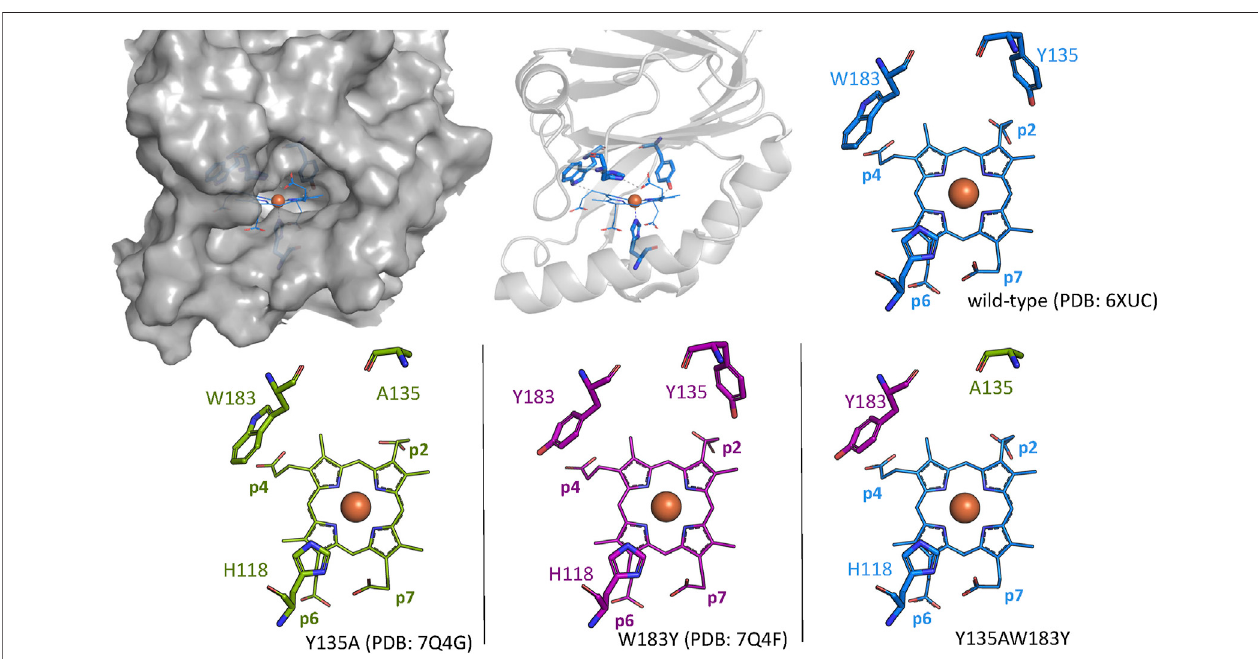
FIGURE 1 | Wild-type Cd ChdC structure is shown as gray surface and cartoon representation. Active site structures of wild-type Cd ChdC (blue), Y135A (green), andW183Y(purple)areshownasstick fi gurerepresentation.CrystalstructureoftheinvestigatedY135AW183Yvariantcouldnotbesolved,andtheexpectedactivesite structure is represented as a combination of the two single mutants from an